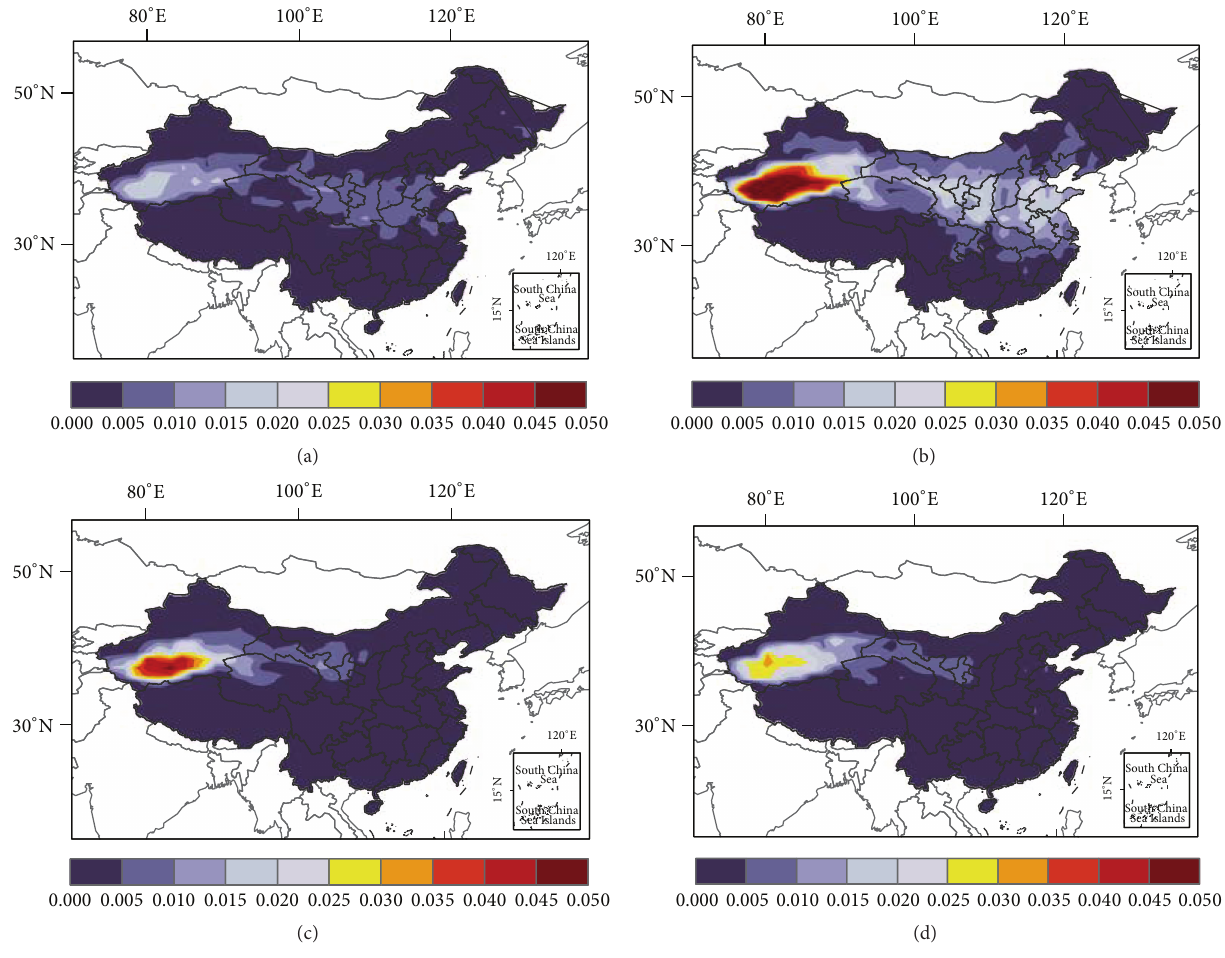
Figure 3: Seasonal mean spatial distribution maps of the C-DAFOD over China from 2007 to 2014. (a) Winter, (b) spring, (c) summer, and (d)